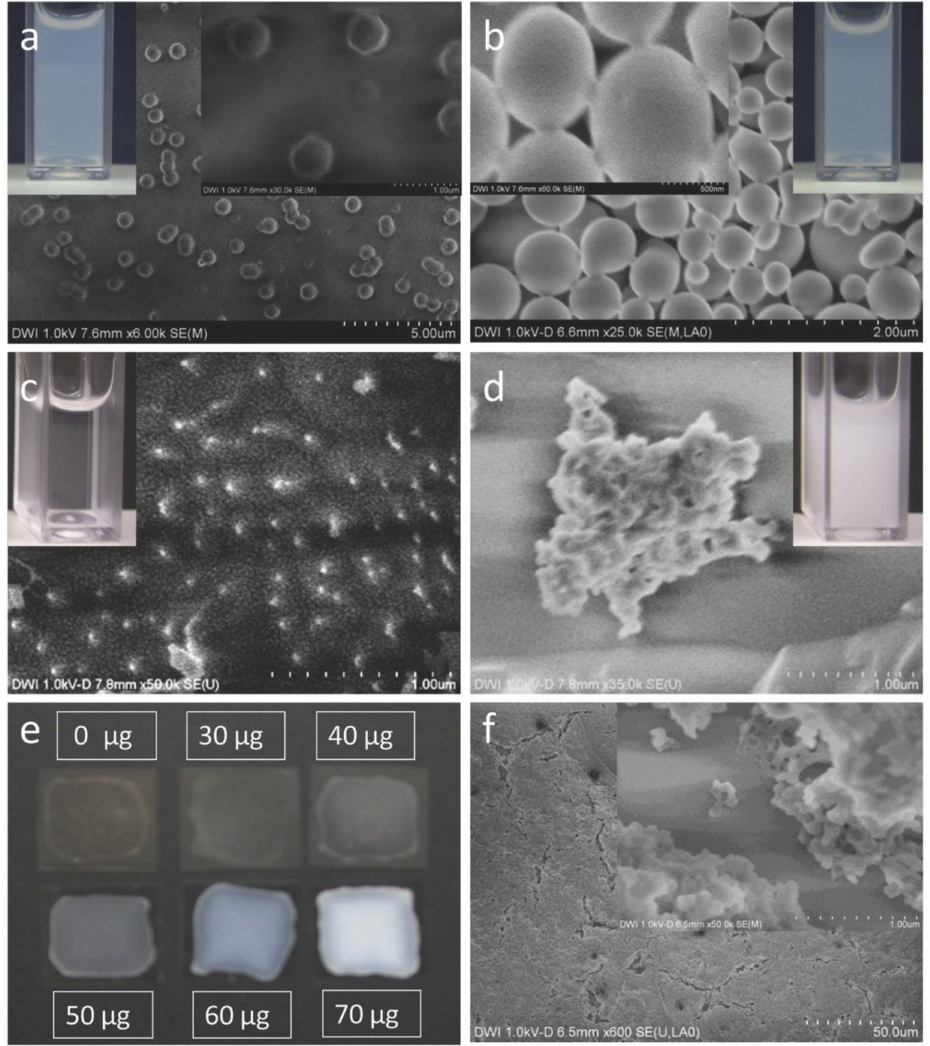
Figure 5. Field-emission-scanning electron microscope (FESEM) images of 0.24 mmol β -CD-MA (DS2) nanogels before ( a ) and after complexation with 70 µ g mL − 1 chlorhexidine (CHX) on alu- minum surface ( b ). Cryo-FESEM image of 0.47 mmol β -CD-MA (DS4) nanogels before ( c ) and after complexation with 70 µ g mL − 1 CHX ( d ). The inset in ( a – d ) shows a dispersion of the β -CD-MA nanogels in a cuvette. Photography of 0.47 mmol β -CD-MA (DS4) nanogels with different CHX content coated on glass plates ( e ) and FESEM images of the nanogel film consisting of the 0.47 mmol CD-MA (DS4) nanogels with 70 µ g mL − 1 CHX ( f ). The second insets in ( a , b , f ) show enlarged